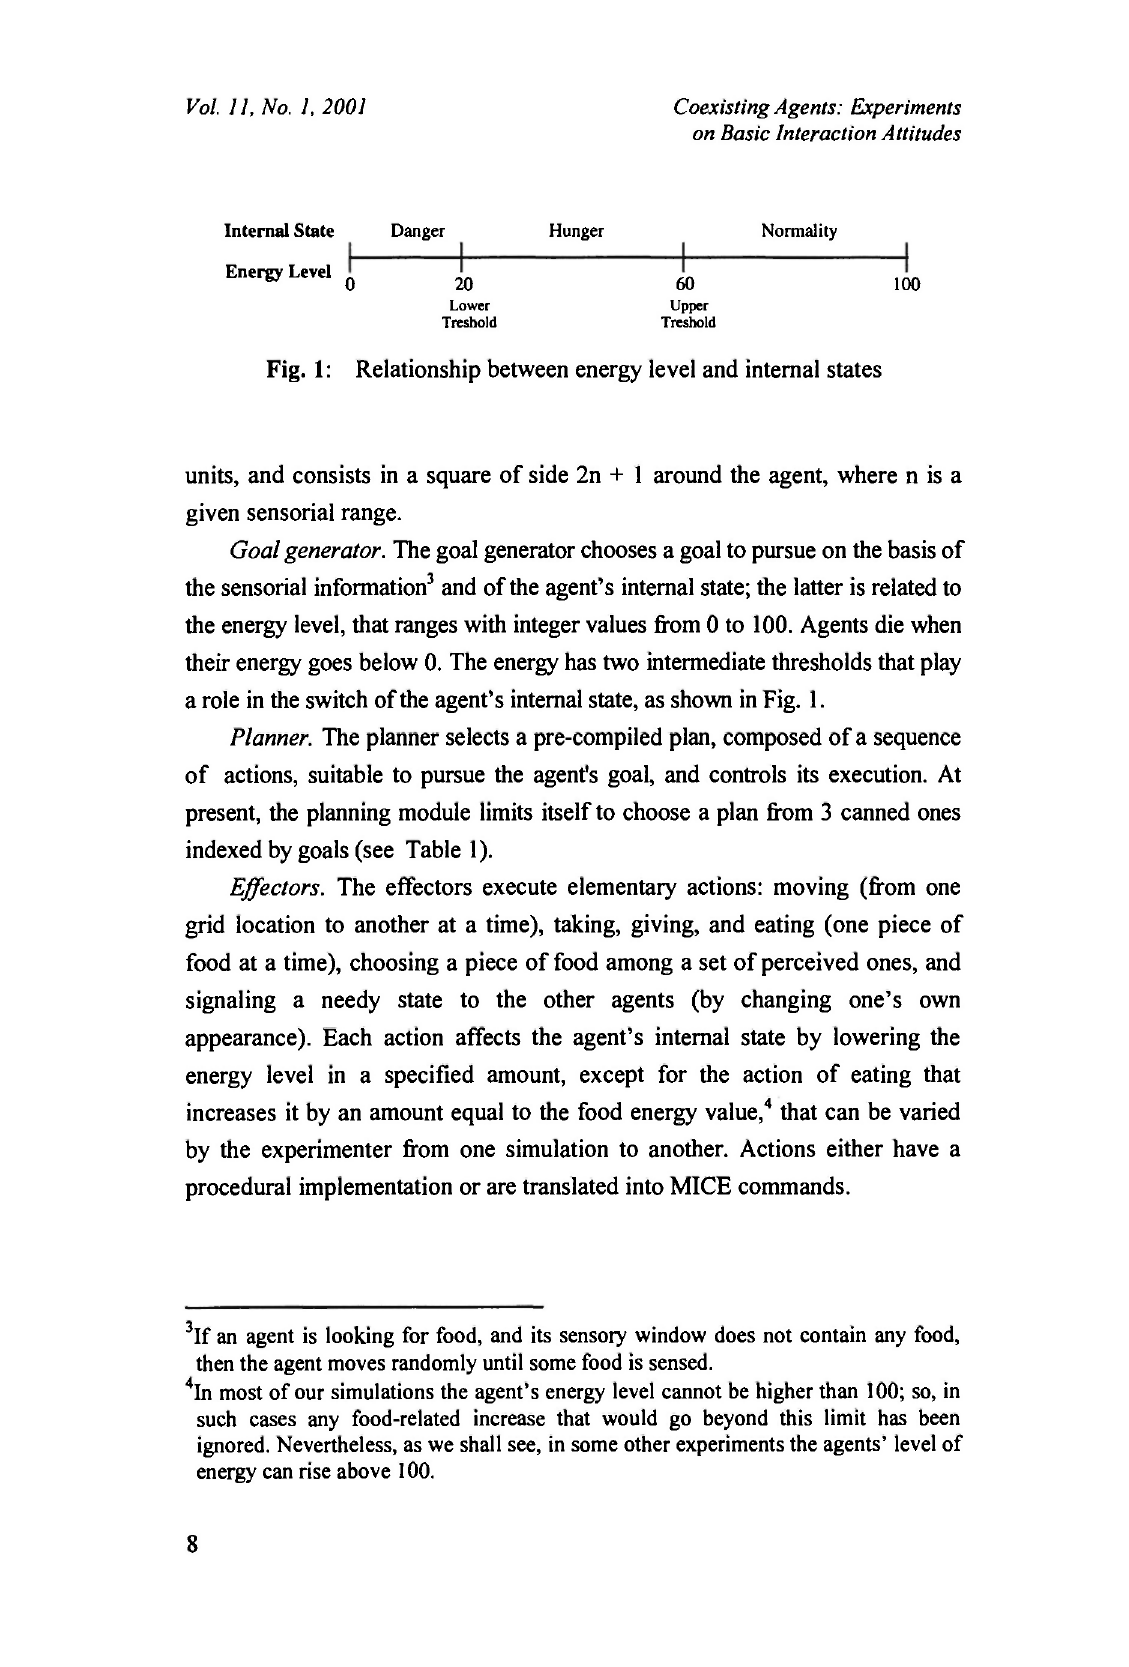
units, and consists in a square of side 2n + 1 around the agent, where η is a given sensorial